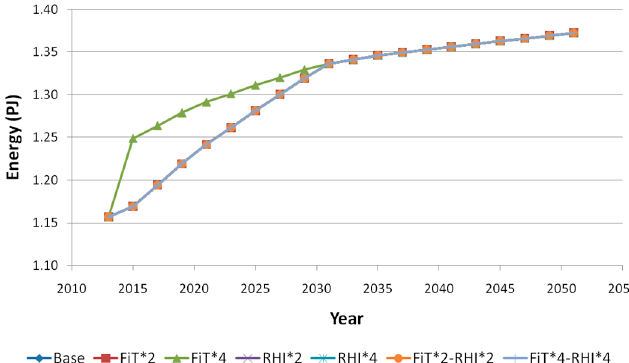
Figure 10. Lowlands farms—grid electricity consumption.